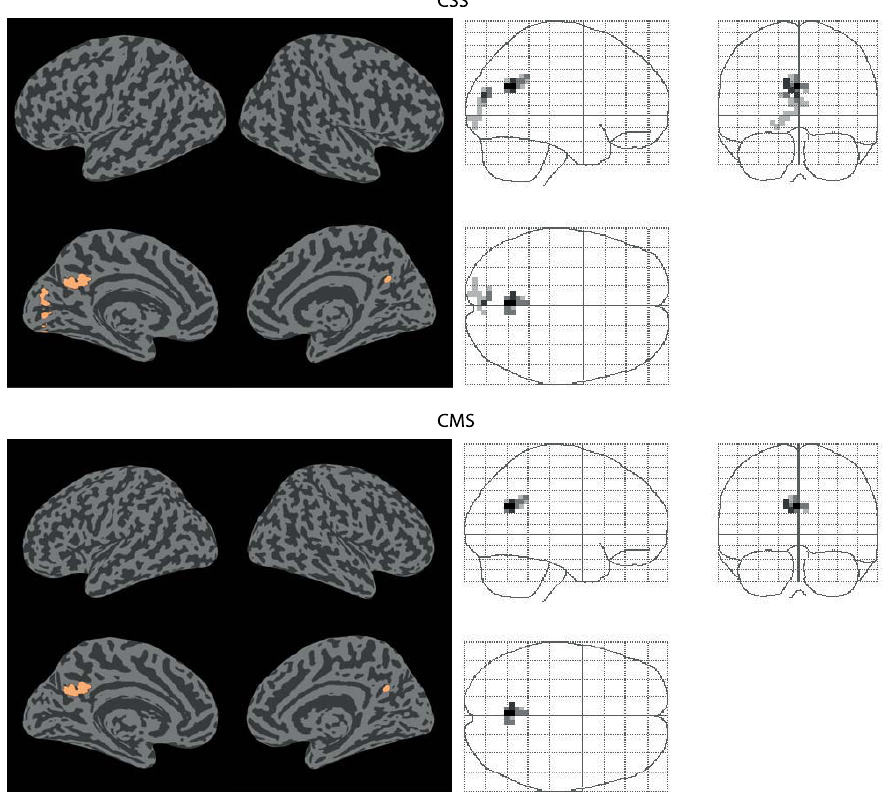
Figure 8. Connectivity increases. Significant (p , 0.05 FWE corrected) increases in functional connectivity between normocapnia and hypercapnia identified by the CSS and CMS statistics.